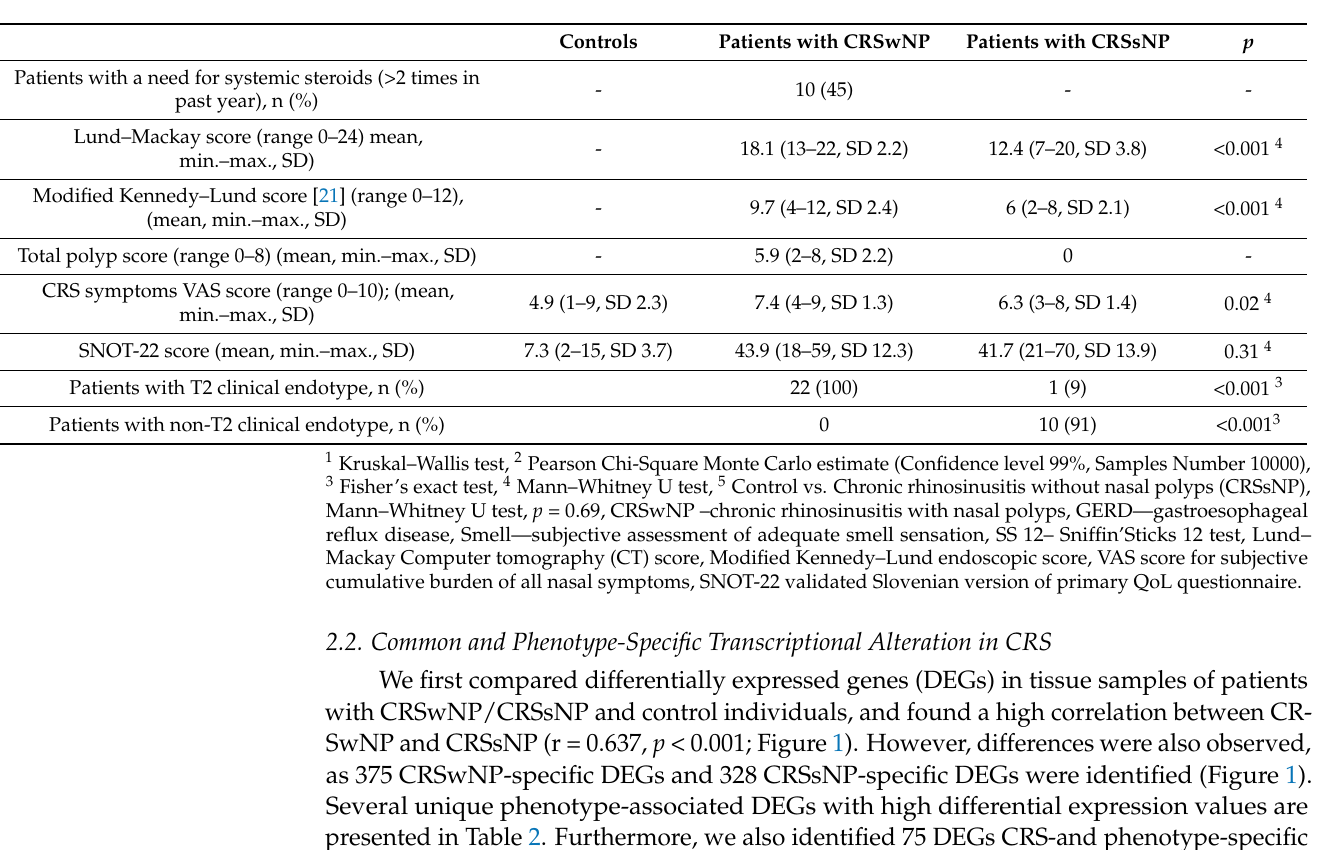
(Figure 1). Several unique phenotype-associated DEGs with high di ff erential expression values are presented in Table 2. Furthermore, we also identi fi ed 75 DEGs CRS-and pheno-